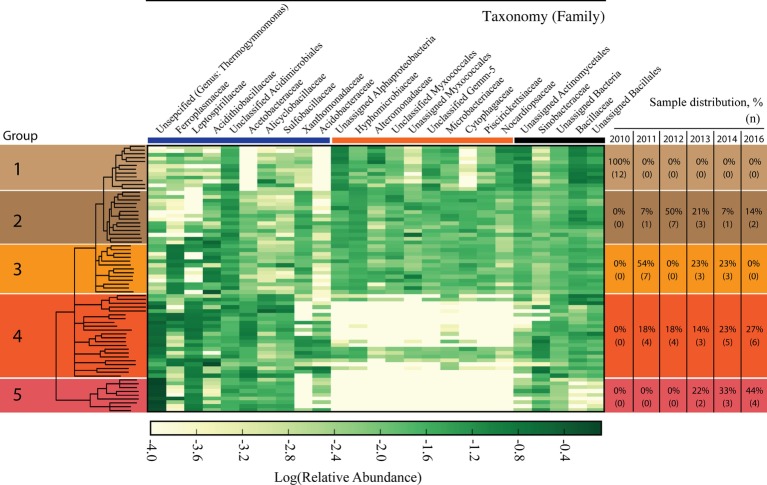
Heat map of microbial families identified in the field study samples. Columns represent family level taxonomy, where families with less than 1% of total relative abundance were removed. Rows represent field samples that have been sorted according to the UPGMA cluster tree generated at the OTU level. The tree is presented in the left column and differentiated into five significantly different Groups (ANOSIM, p < 0.01, R = 0.65). Nodes with a support value less than 0.5 were collapsed. Relative abundance values have been log transformed and any class that had zero sequence reads has been manually set to −4.0. Darker colors represent more abundant families and whiter colors are less abundant families. The right hand column denotes the distribution of when samples in each of the five Groups were collected. The percentages represent the samples that were collected in each year for a given Group; the number of samples (n) present in a year for the Group is given in parenthesis below. The bolded colored lines between the top of the heatmap and family names break the taxonomic families into three sections; the blue line denotes families that are associated with acid mine drainage, orange line denotes families that are strongly selected against in Groups 4 and 5, and the black line denotes other families.